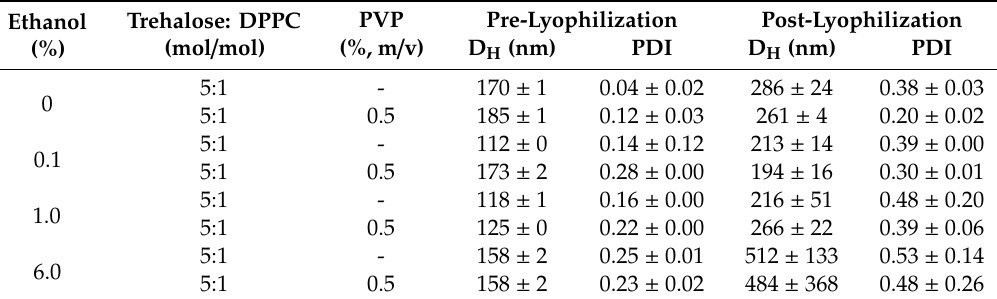
Figure 4. Cakes obtained after lyophilization of formulations with 1% v/v ethanol content ( A ) and 0.1% v/v ethanol content ( B ): Figure 4A clearly evidences the phenomenon of “product ejection”. Table 5. Dynamic light scattering (DLS) results on liposomes before freeze-drying and after rehydration: All samples were freeze-dried according to method